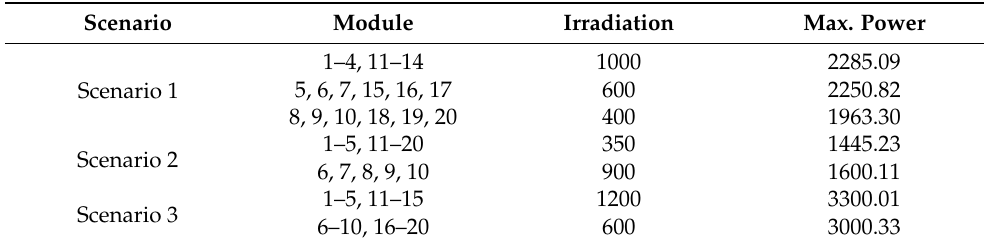
Table 5. Partial shading distributions of each scenario from the PV curves.